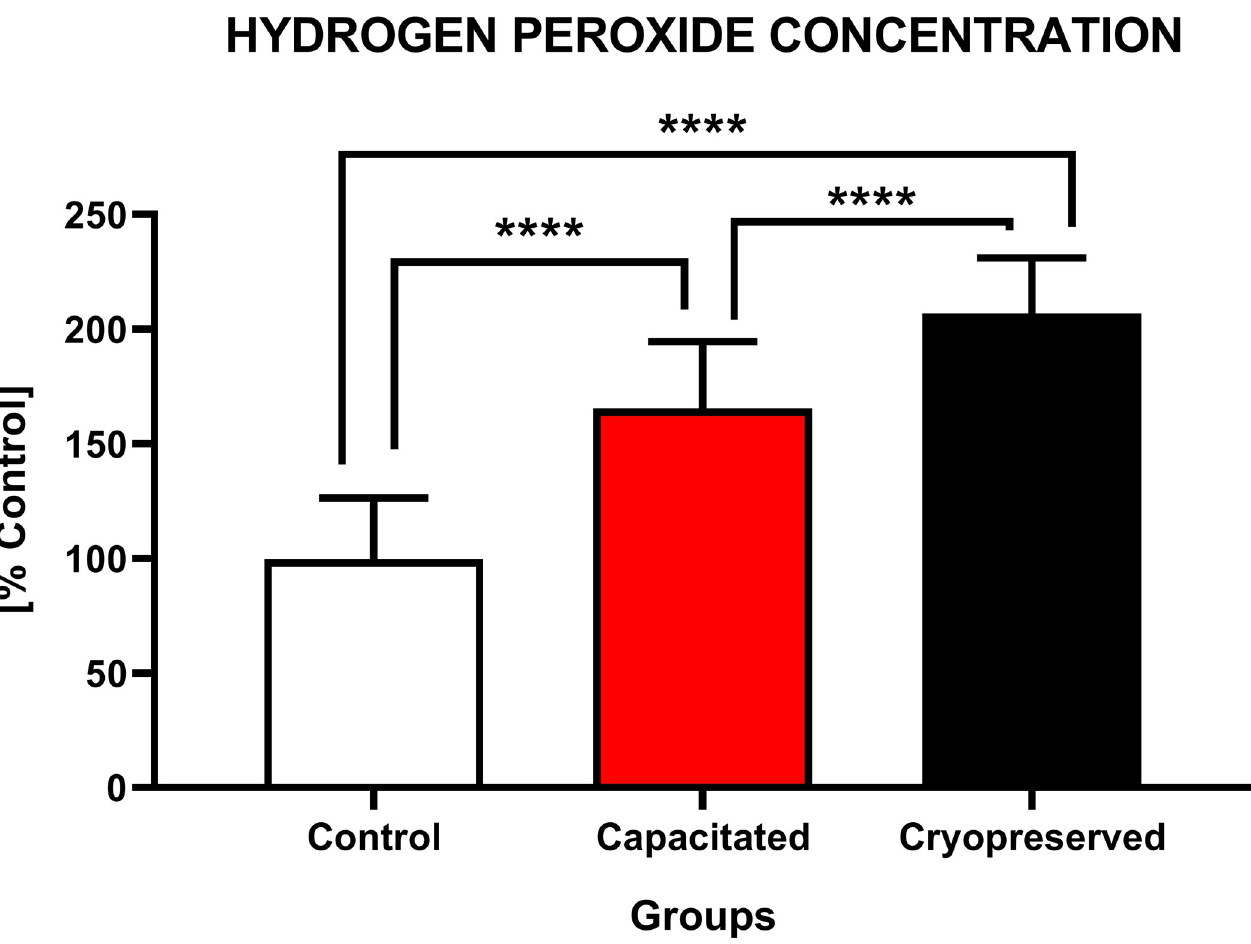
Fig 12. Intracellular production of hydrogen peroxide of non-capacitated, in vitro capacitated and cryopreserved bovine spermatozoa. The graph represented the concentration (%) of hydrogen peroxide in each group ( ± SD). The level of significance was set at � P < 0.05; �� P < 0.01; ��� P < 0.001; ���� P <